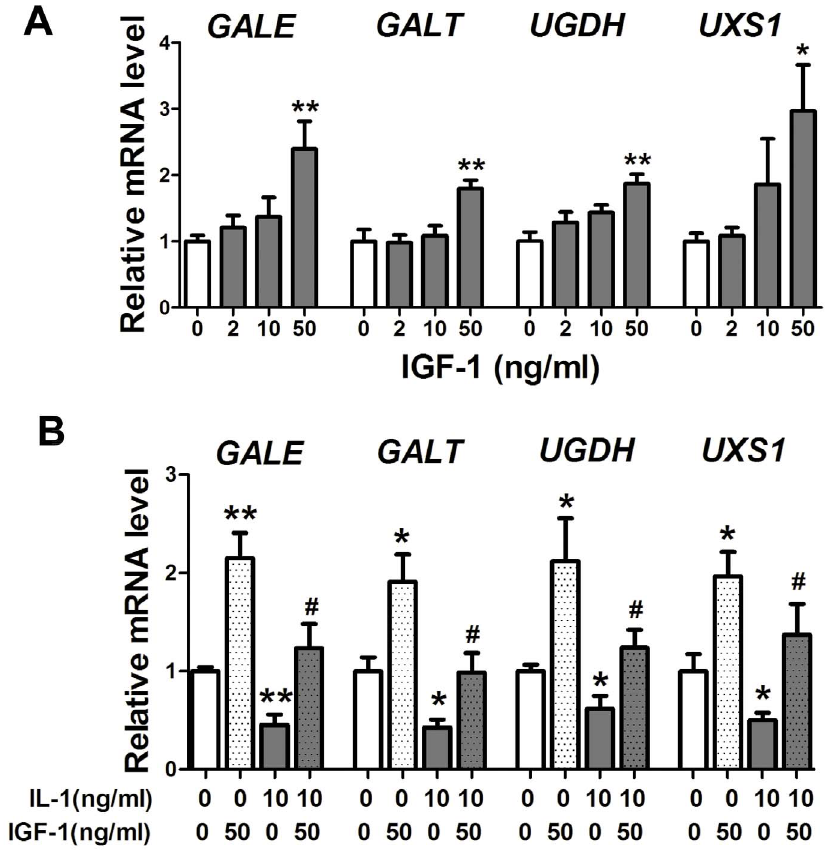
Figure 6. Insulin like growth factor (IGF1) modulated UDP-sugar synthases (USSs) gene expression invitro . A, The mRNA expression of the USSs was detected in human primary chondrocytes treated with recombinant human IGF1 (2, 10 and 50 ng/ml) for 48 h. B, Chondrocytes were pre-treated with 10 ng/ml interleukin 1beta (IL-1 b ) for 30 min, then co-treated with the IL-1 b and 50 ng/ml IGF1 for 48 h. Then, mRNA level of the USSs was detected. Values were presented as mean 6 SEM from at least two independent experiments. * P , 0.05 versus control group; # P , 0.05 versus IL-1 b group.